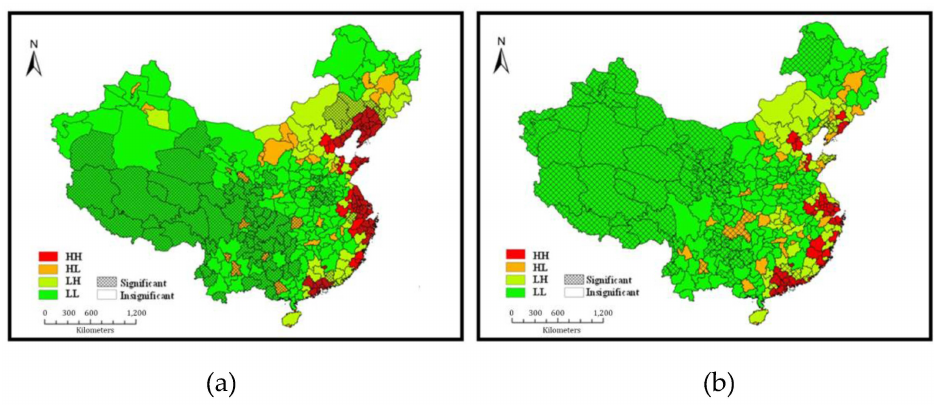
Figure 5. Local spatial autocorrelation analysis of ( a ) KFC and ( b ) McDonald’s